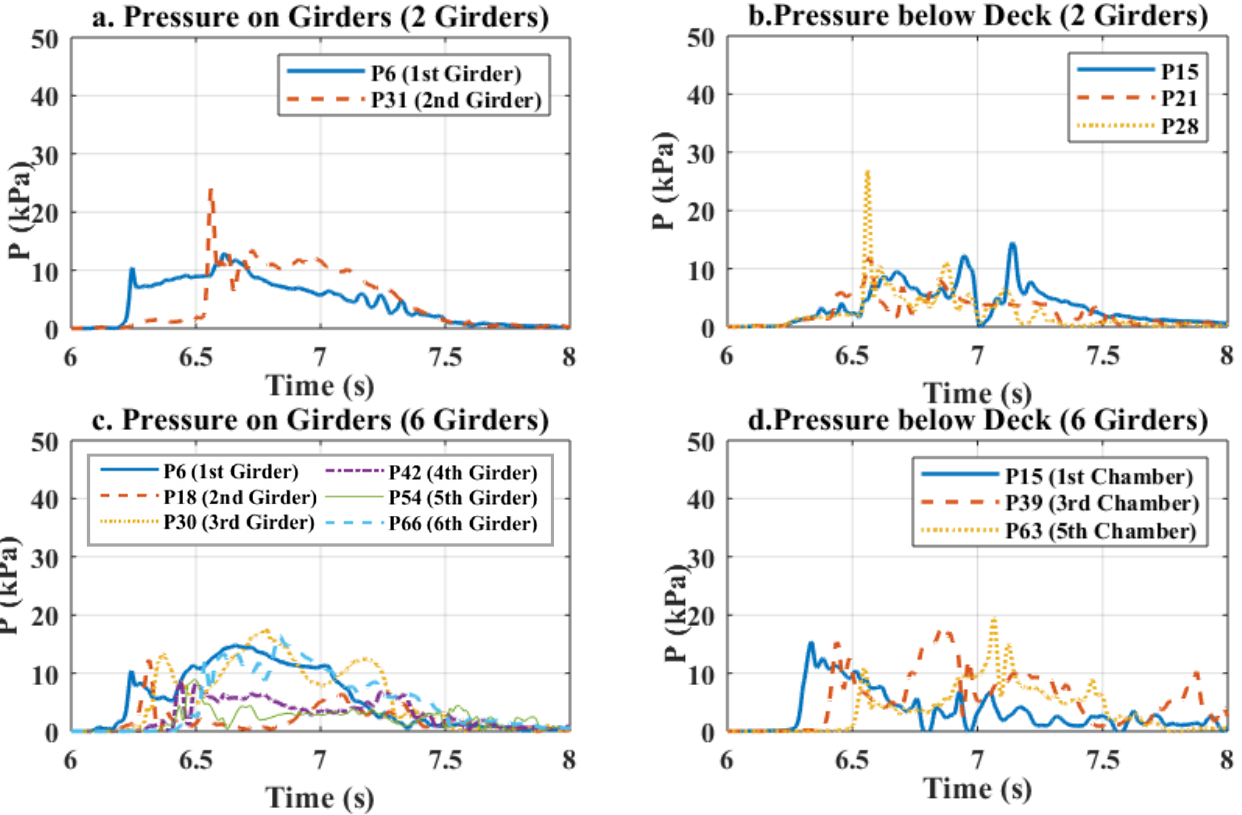
Figure 13. Pressure histories on girders ( left ) and below the slab ( right ) for the deck with two girders ( top ) and six girders ( bottom ) for wave SW3.6 ( H = 0.85 m)